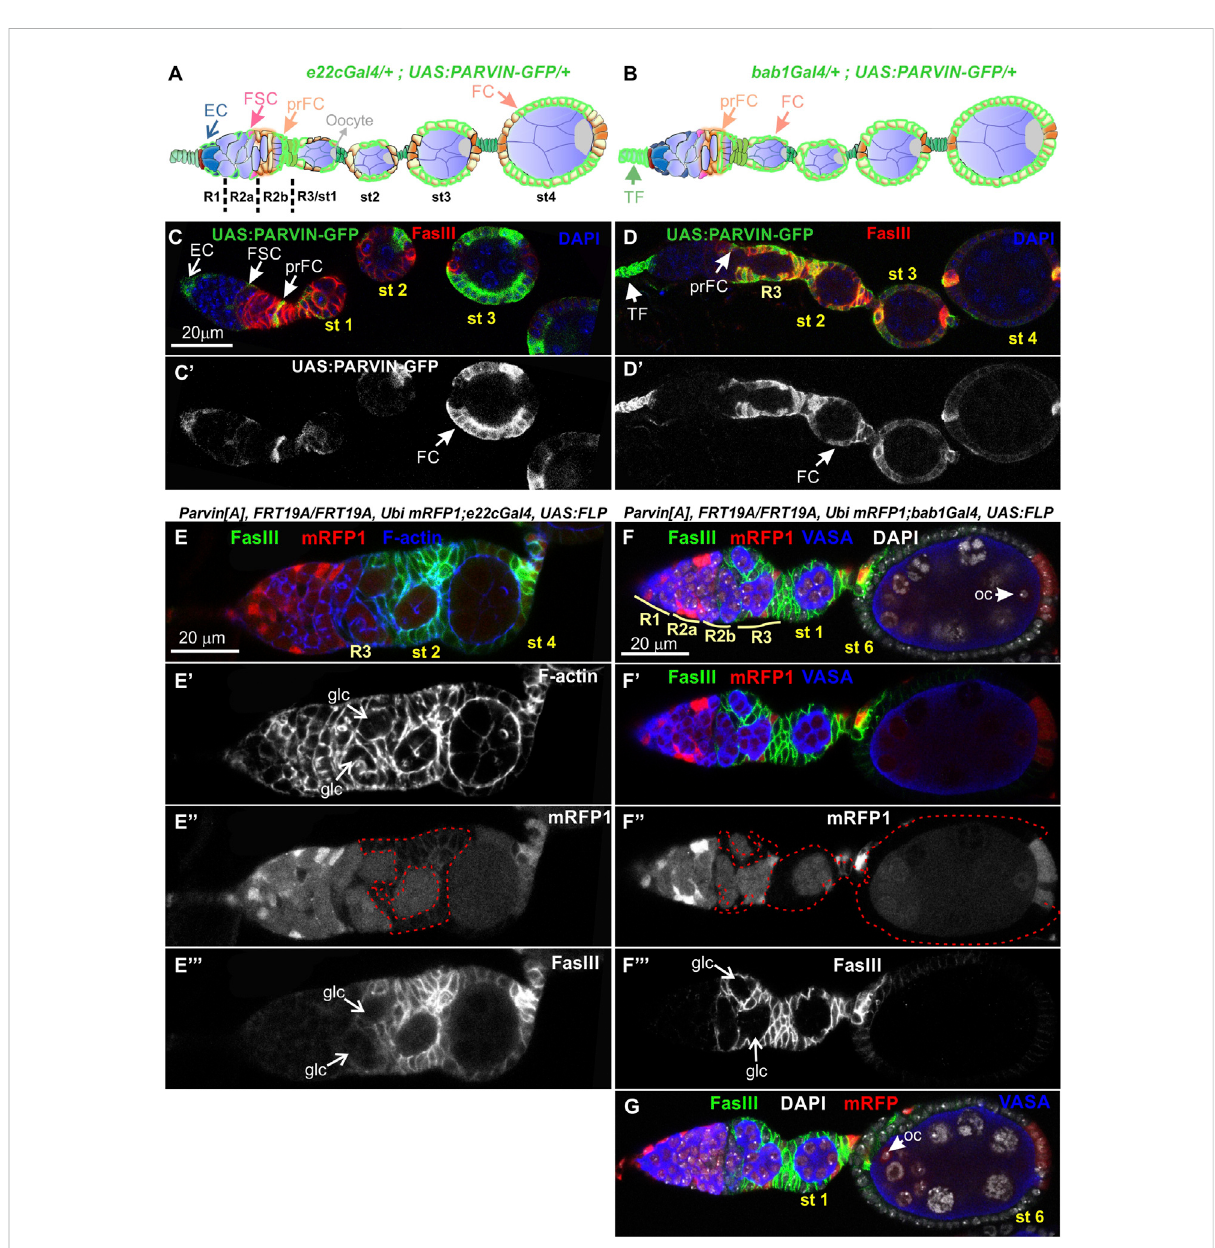
FIGURE 7 Genetic mosaics for Parvin display germline cyst encapsulation defects resulting in compound egg chambers. (A,B) Graphic illustration and expressionpatterncharacterizationintheeggchambersof (A) e22cGal4 and (B) bab1Gal4 ,derivedfromadult fl iesexpressingUAS:Parvin-GFP. (C,D) Confocal micrographs illustrate that (C-C 9 ) e22cGal4 is expressedin theescort cells in the anterior part of the germarium, in thefollicle stem cells at the interface between regions 2a and 2b and in almost all follicle epithelial cells after stage 2. (D-D 9 ) bab1Gal4 is expressed in terminal fi lament cellsintheanteriorpartofthegermarium,inthepre-follicle cellsofthegermarium, inpolarcells andinalargefraction offollicle epithelial cellsafter stage 2. (E-E - ) , (F-F - ) , (G) Confocal micrographs of egg chambers derived from Parvin A mosaic fl ies generated by (E-E - ) e22cGal4 or (F-F - ) , (G) bab1Gal4 . (E"-F") Parvin A mutant cells were marked by the absence of mRFP1 and are highlighted with a red dashed line. Two cysts in region 2b are enclosedin Parvin A mosaiceggchambersgeneratedwitheitherofthe Gal4 drivers (F) and (G) aredifferentopticalsectionsofthesameeggchamber to reveal the compound egg chamber presence at stage 6, which contains two oocyte nuclei. The oocyte nuclei are located in the posterior (F) and the anterior (G) end of the egg chamber containing a large Parvin A mutant clone. (E 9 ,F 9 ) F-actin and (E - ,F - ) FasIII label the periphery of the follicle epithelialcells,whileVasalabelsthegermcells.EC,EscortCell;FSC,FollicleStemCell;TF,TerminalFilament;prFC,pre-FollicleCell;FC,FollicleCell; Oc, Oocyte; glc, germline cyst. Scale bars: 20 μ m in all